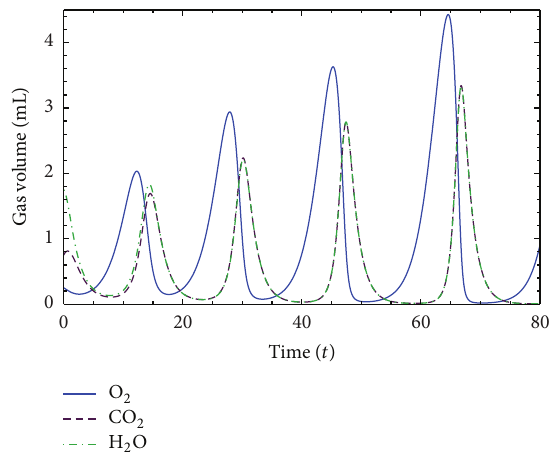
Figure 6: Phase diagram with unstable trajectories. Here 𝐾 = 9 and 𝑢 = 0.7 .